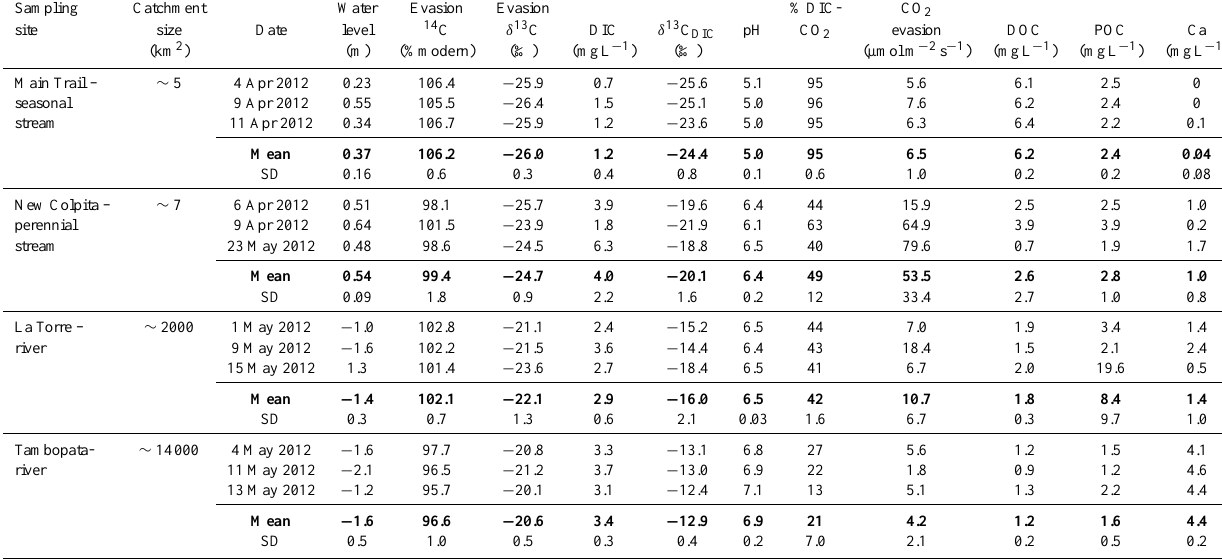
Table 2. The mean evasion 14 C and δ 13 C signatures, total DIC pool concentration, δ 13 C-DIC, pH, fraction of the DIC pool in the form of CO 2 , DOC, POC and Ca concentrations in the studied drainage systems in Tambopata region, Peru. The drainage systems were sampled three times targeting different hydrological conditions: baseflow, rising water and falling water. In the case of the small streams, water level is the stream depth; in larger rivers the measurement is a relative change in water level. At the time of sampling, April–May 2012, the estimated 14 C of the atmosphere was ∼ 103.8%modern (Levin et al., 2008). The analytical uncertainty was ± 0.1‰ and ± < 0.5%modern for evasion δ 13 C and 14 C measurements,